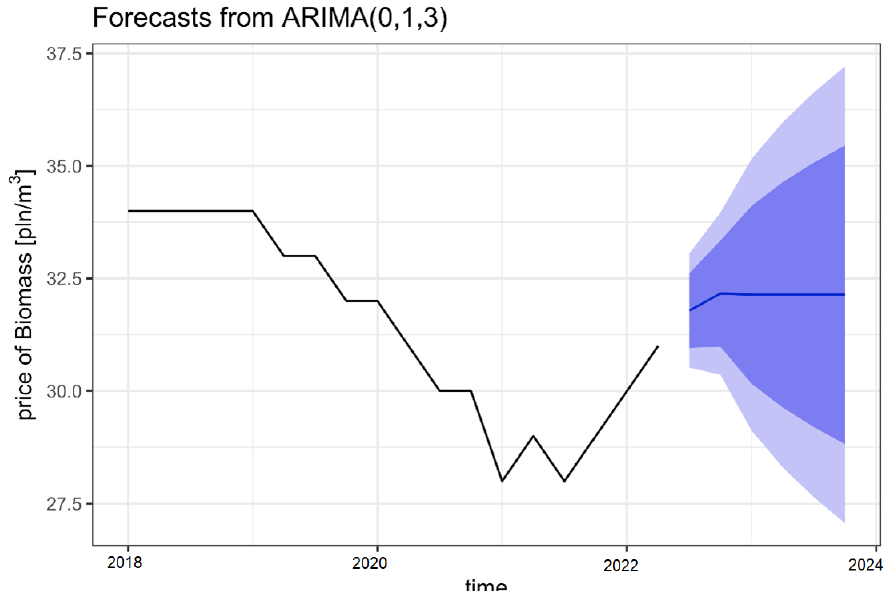
Figure 5. Price forecast for the M2 assortment in Q3 of 2022, Q4 of 2022, and Q1 of 2023. Source: Own elaboration based on data obtained from the State Forests IT System (SILP).